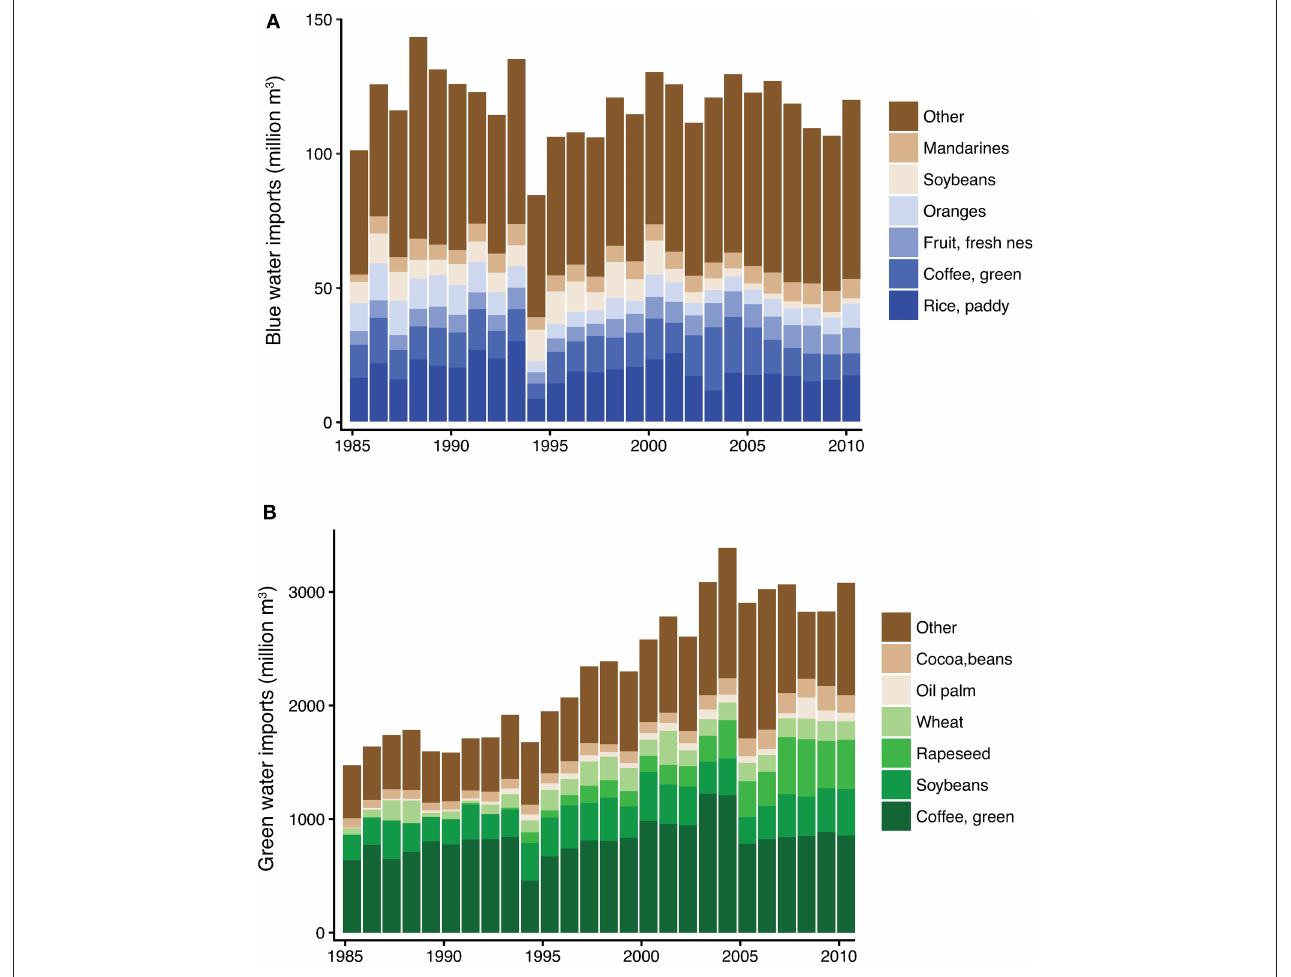
FIGURE 2 | Blue water (A) and green water (B) imports of the main crops imported to Finland during 1986–2011.